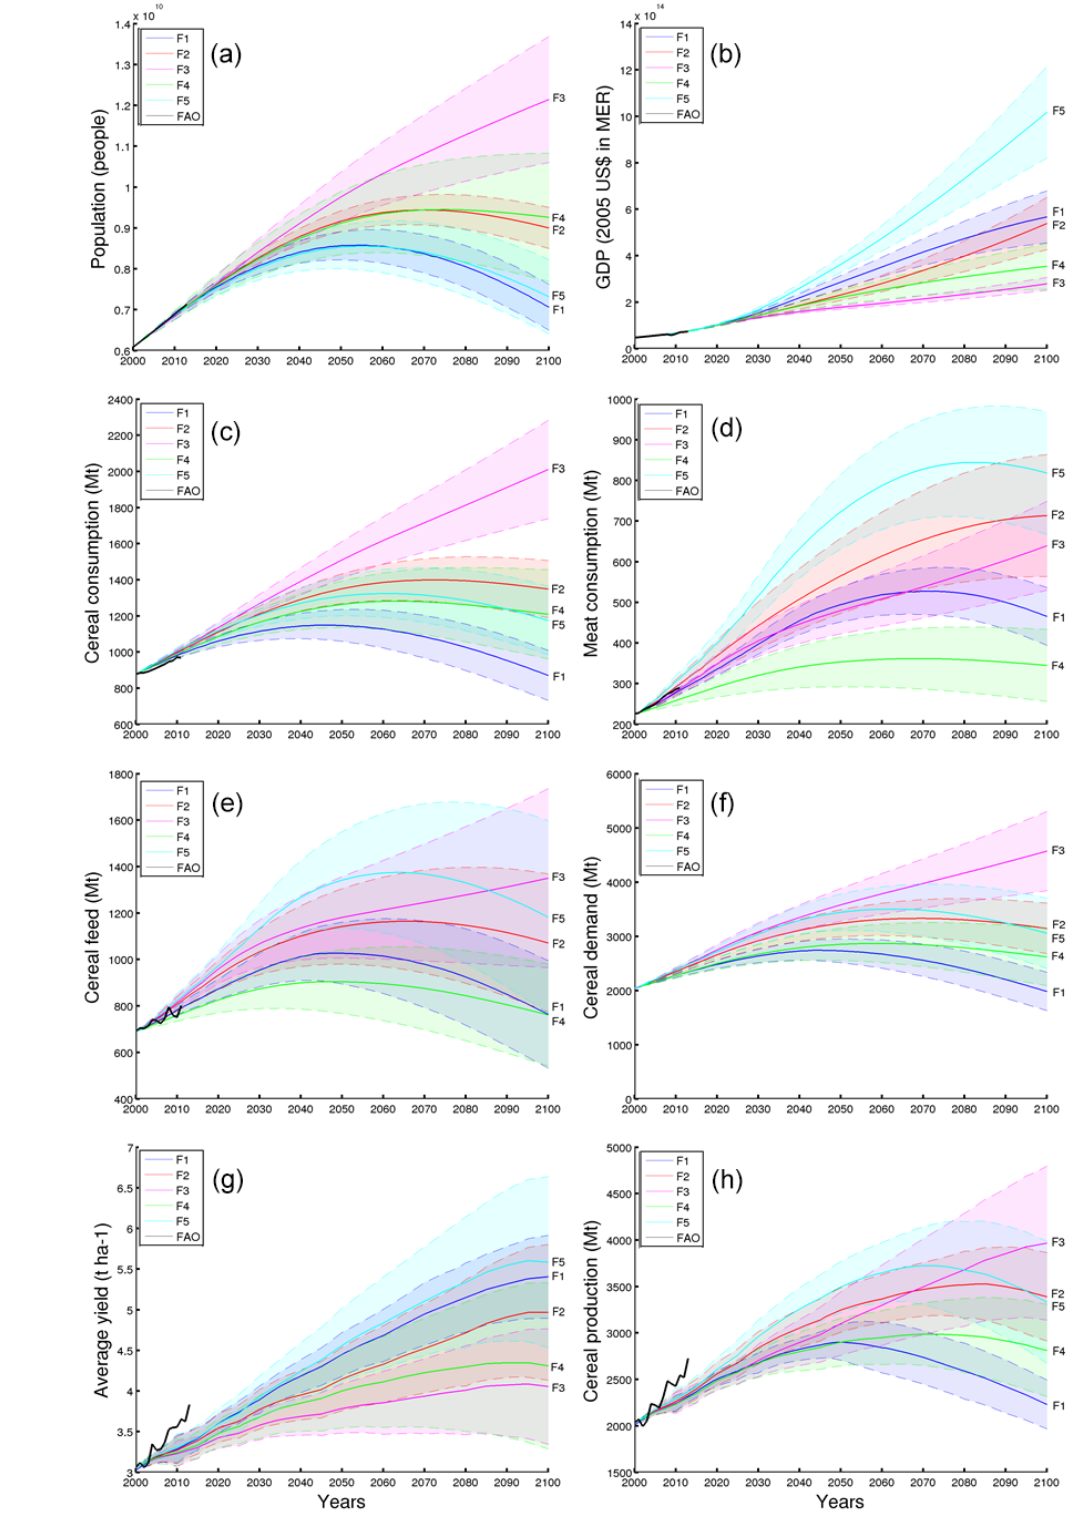
Figure 4. Global population, GDP, cereal consumption, meat consumption, cereal feed, cereal demand, mean cereal yield and cereal pro- duction for the five scenarios F1–F5. Solid lines indicate the scenario mean; dashed lines indicate the range based on the mean ± 2 standard